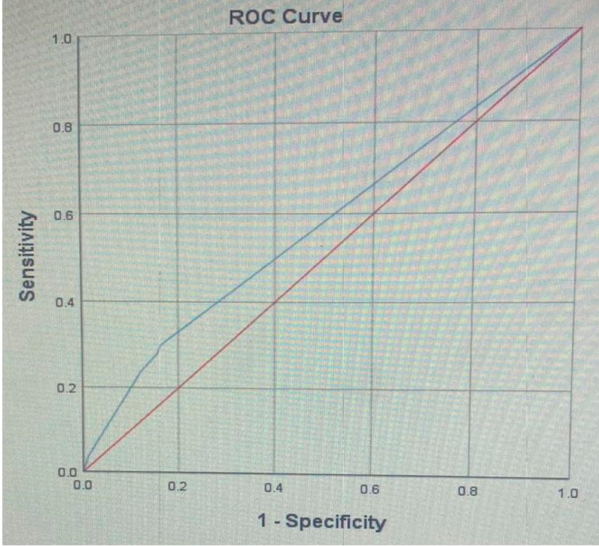
Figure 1. A receiver operating characteristic (ROC) analysis of the dental inflammation score (DIS) as predictor of hypertension: Area Under the Curve (AUC): 0.57